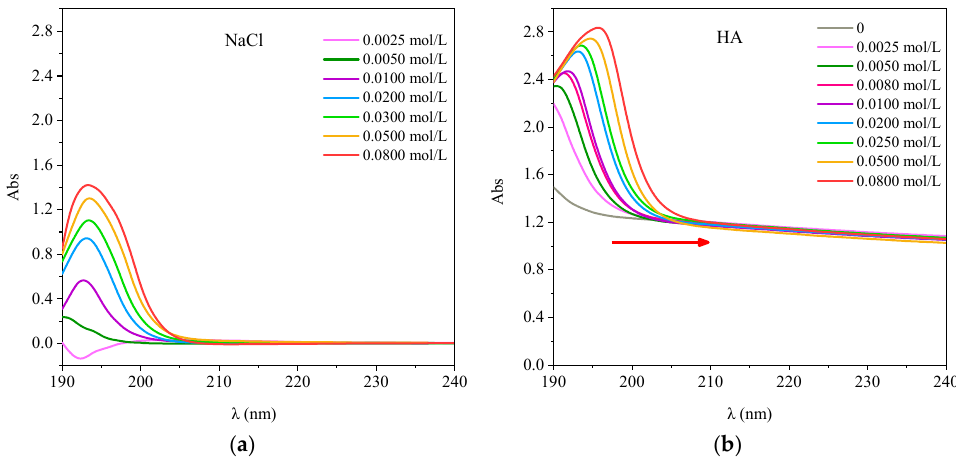
Figure 10. UV- visible spectra of the different concentration of NaCl and HA with different ionic strength. ( a ) OTC; ( b ) SD.